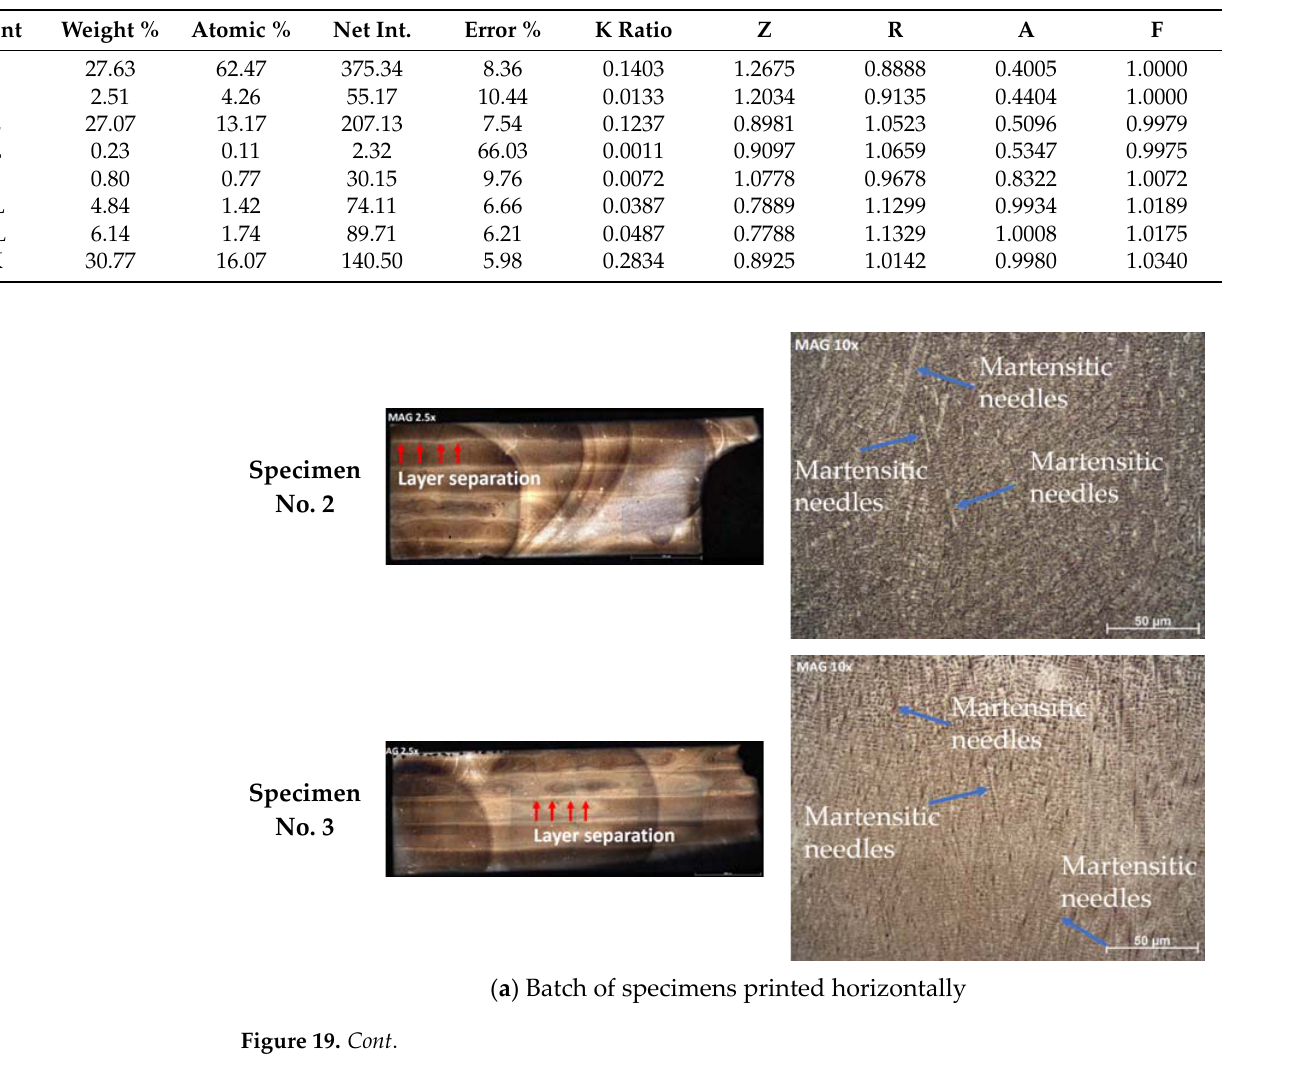
Table 9. Chemical composition as the result of EDS analysis in specimen No. 5 (second point) to study the lack of fusion defect.